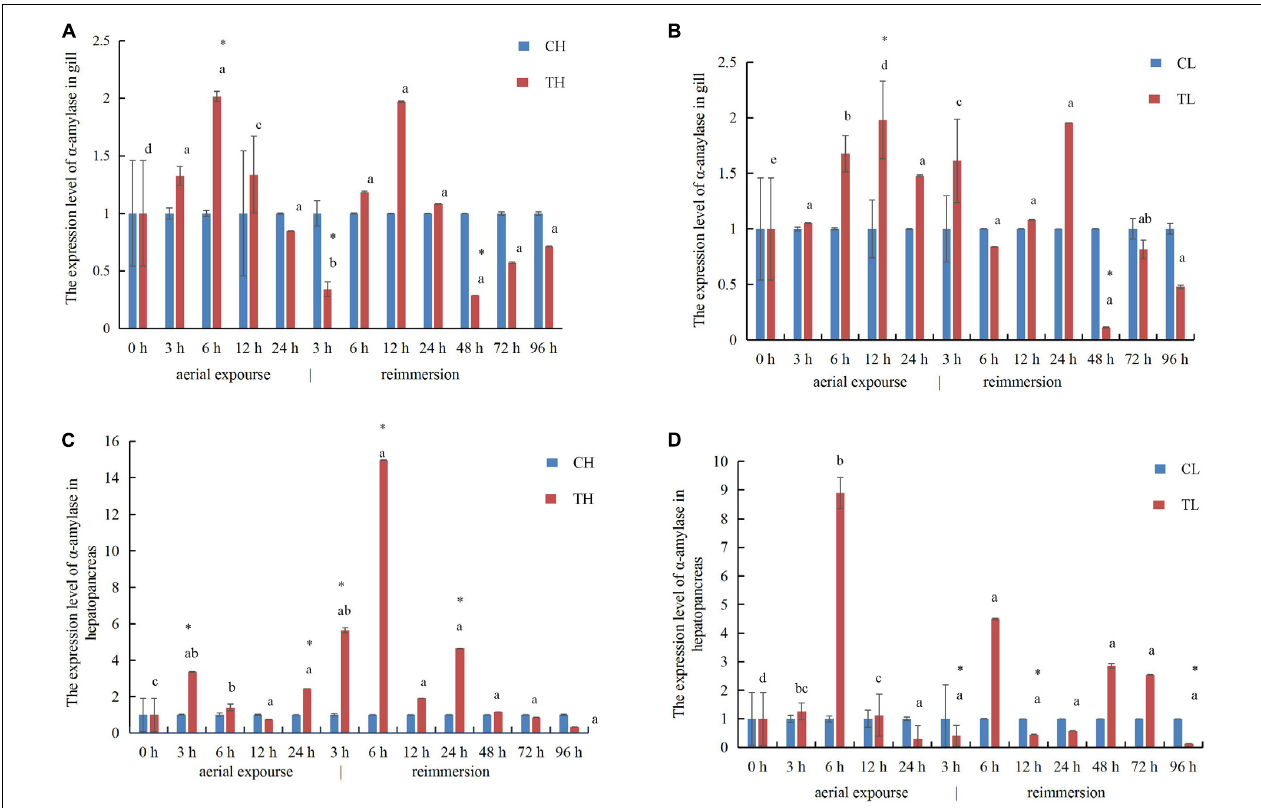
FIGURE 8 | The expression analysis of α -amylase in the gill of R. philippinarum under aerial exposure and reimmersion at high (A) and low temperature (B) . The expression analysis of α -amylase in the hepatopancreas of R. philippinarum under aerial exposure and reimmersion at high (C) and low temperature (D)